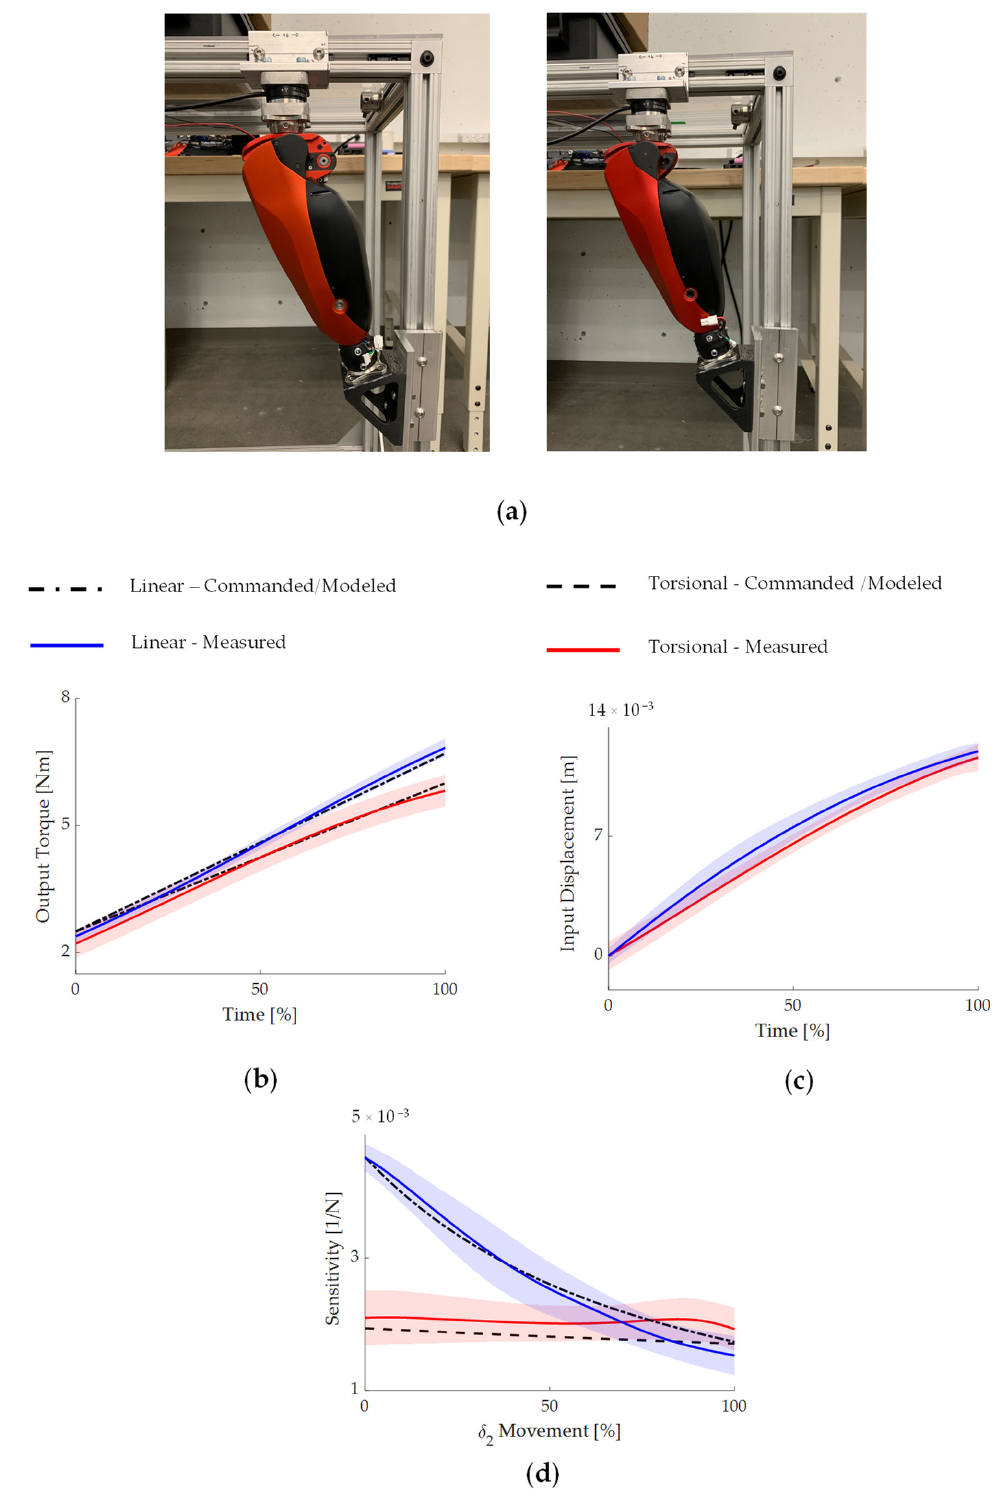
Figure 6. Output torque tracking and sensitivity quantification on the bench. ( a ) Experimental setup. The knee joint was fixed in a testing rig, and a 6-axis loadcell measures the output torque. ( b ) Commanded and measured output torque. ( c ) Measured input displacement. ( d ) Modeled and measured sensitivity. Results are shown for both implementations.